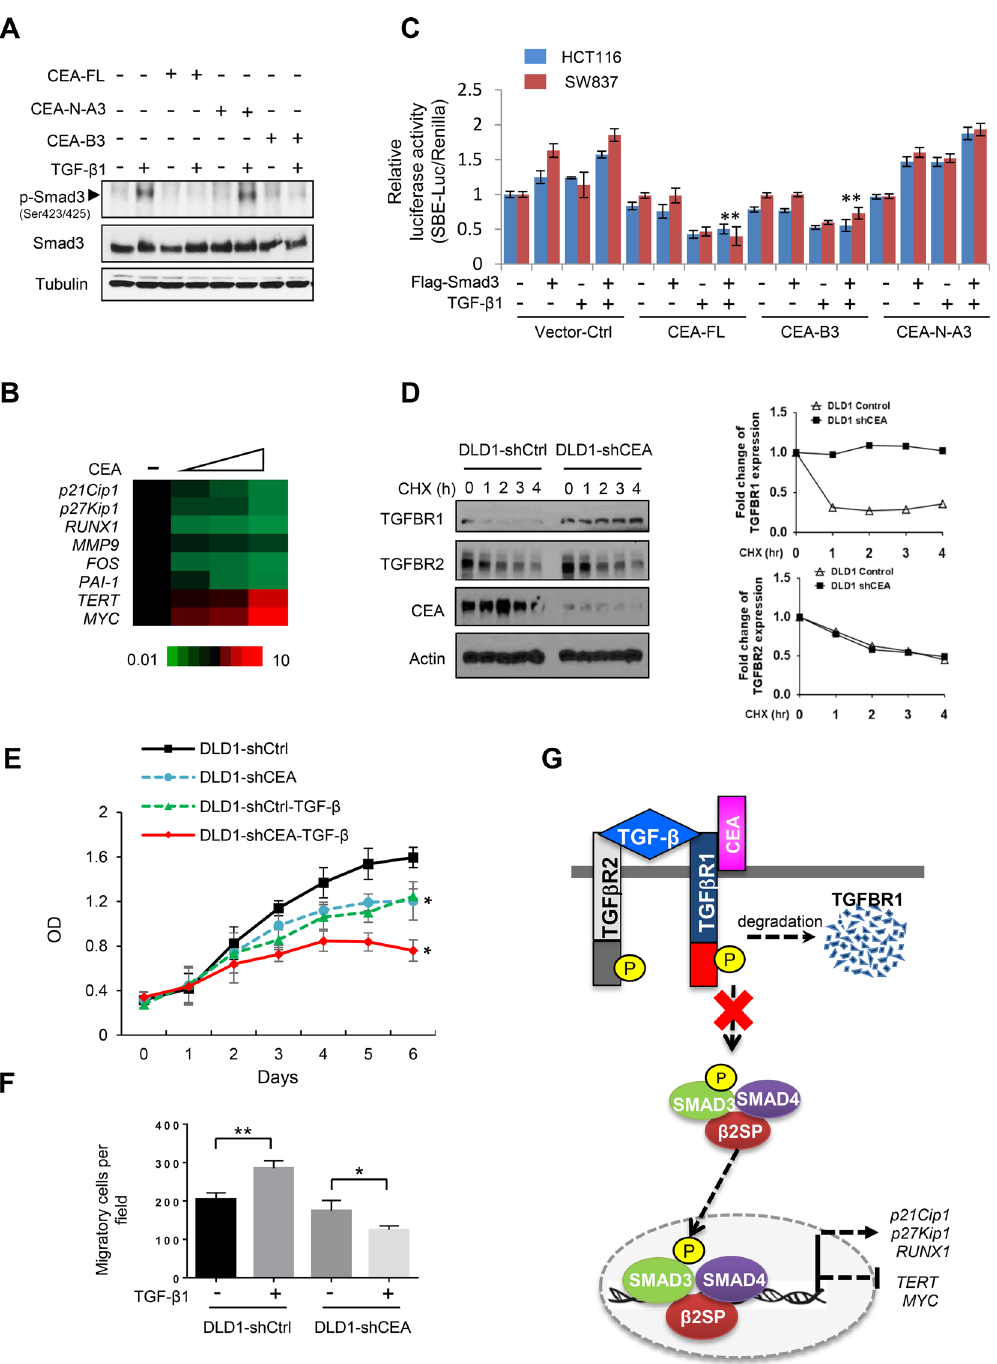
Fig 5. CEA interacts with and disrupts the TGF- β pathway. (A) Overexpression of CEA B3 domain prevents TGF- β -induced Smad3 phosphorylation. HCT116 cells were co-transfected with CEA wild type (FL) or various CEA deletion mutants. The cells were stimulated with TGF- β 1 for 2 hours. The cell lysates were immunoblotted with the indicated antibodies. (B) CEA transcriptionally regulates TGF- β pathways. HCT116 cells were transfected with CEA. The mRNA levels of TGF- β targets were detected by Q-RT-PCR. The result shown is representative of three independent experiments. (C) Overexpression of CEA B3 domain inhibits Smad3 transcriptional activity. HCT116 or SW837 cells were co-transfected with Smad3 luciferase reporter plasmids, CEA (FL, N-A3, and B3), and Renilla luciferase reporter plasmids. The cells were stimulated with TGF- β 1 for 2 hours. Cell lysates were collected and analyzed according to the manufacturer ’ s protocol. Results are the average of three independent experiments and are presented as mean ± SD. * p < 0.01, compared with Flag-Smad3/TGF- β 1 treatment in Vector-Ctrl cells. Student ’ s t-test. NS: not significant. (D) CEA knockdown increases TGFBR1 protein stability. DLD1 cells were knocked down with control or shCEA. Cells were treated with 100ug/ml cycloheximide (CHX) for the indicated times. The density of TGFBR1 or